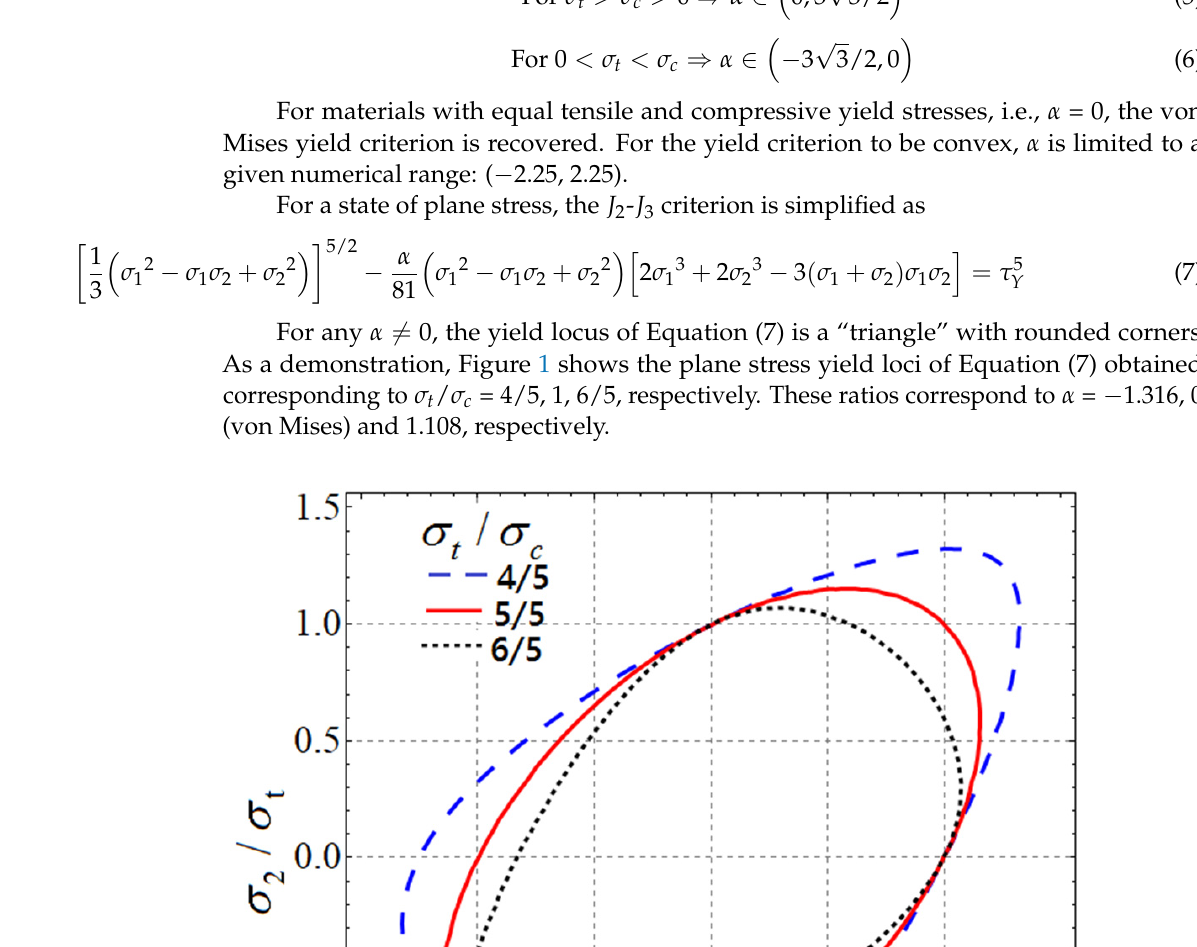
/ σ σ = 4/5, 5/5 (von t c